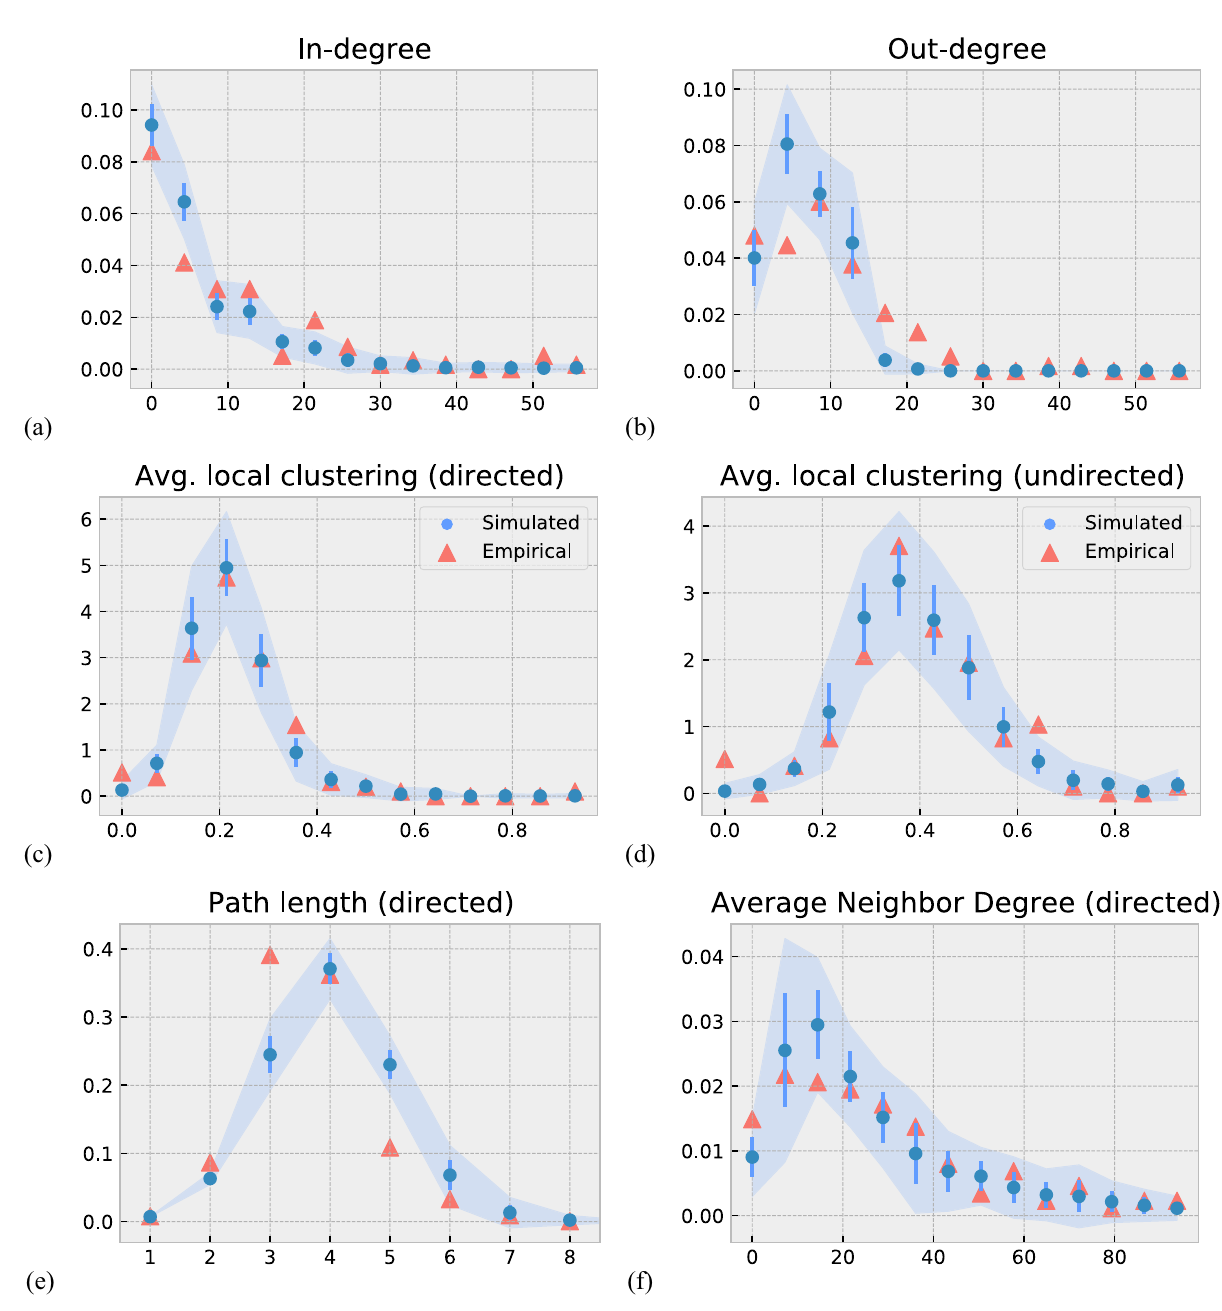
Figure 5. Comparison of empirical and simulated topological properties of the mobility network. Distributions of ( a ) in-degrees, ( b ) out-degrees, ( c ) local clustering coefficients (directed) ( d ) local clustering coefficients (undirected), ( e ) path lengths and ( f ) average neighbor in-degree. Red triangles indicates the empirical distribution, and blue circles distributions obtained from the simulation. The error bars correspond the standard deviations of 30 realisations of the simulation and the bands the 95% confidence